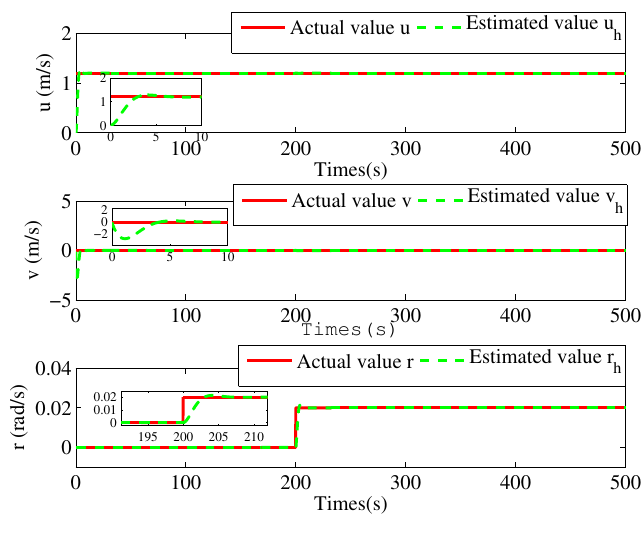
Figure 5. The estimate value of the finite time observer module.